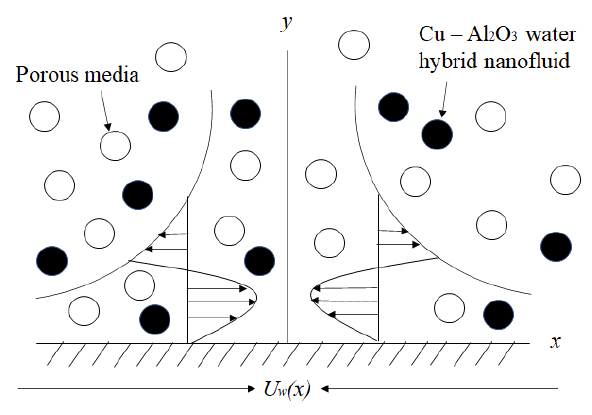
Figure 1. The system of coordinate and model that moving in a shrinking